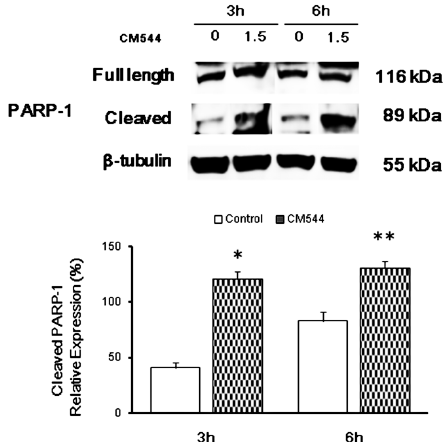
Figure 6. PARP-1 activation in C6 rat glioma cells in the presence of CM544. Representative protein bands of PARP-1 obtained by Western blot analysis. β -tubulin expression is used as protein content marker. Typical results from one of three independent experiments are shown. Densitometric values are expressed as percentages of the integrated optical intensity of protein bands normalized on β -tubulin. ** p < 0.01 treated vs. control (untreated cells).